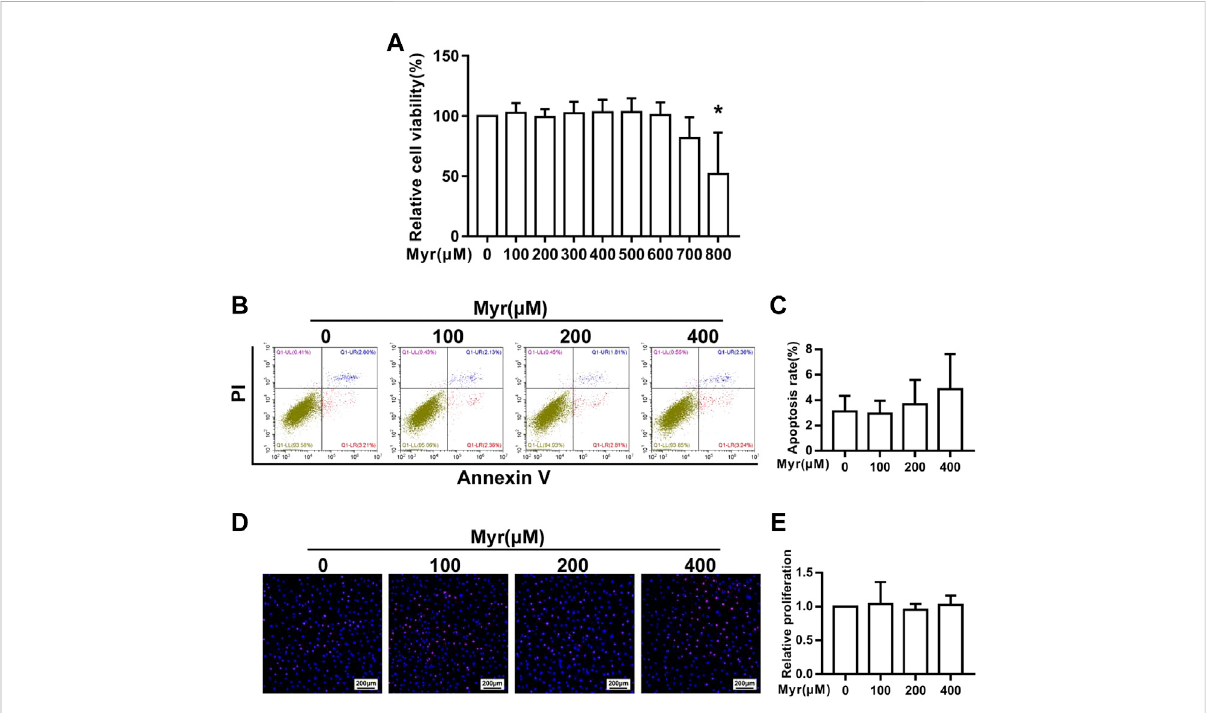
FIGURE 1 Effect of Myr on the viability, proliferation and apoptosis of RA FLSs. The cells were treated with Myr at different concentrations (0 – 800 μ M) for 24 h. (A) The CCK-8 assay was used to detect the cell viability. (B,C) Effect of Myr on the apoptosis of RA FLSs. Cell apoptosis was detected by a fl ow cytometry-basedAnnexinV-APC/PIassay.Representativeimagesareshown. (D,E) EffectofMyrontheproliferationofRAFLSs.Cellproliferationwas assessed by the EdU assay. Representative images are shown (original magni fi cation, ×100). The data are expressed as the mean ± SD from at least 3 independent experiments. * p < 0.05 versus DMSO